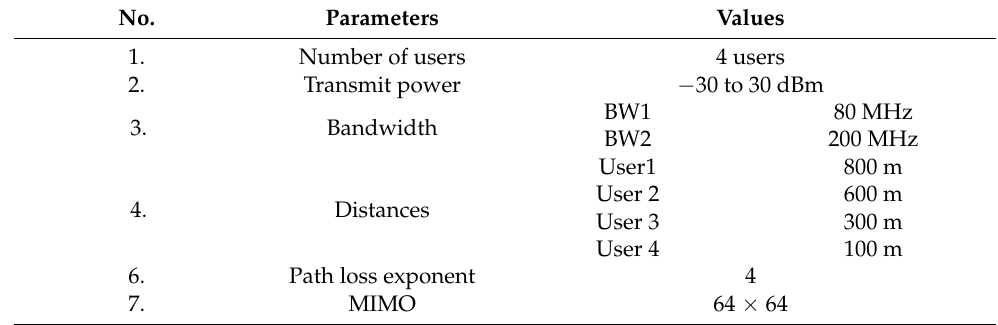
Table 2. Simulator parameters for the UL scenario.